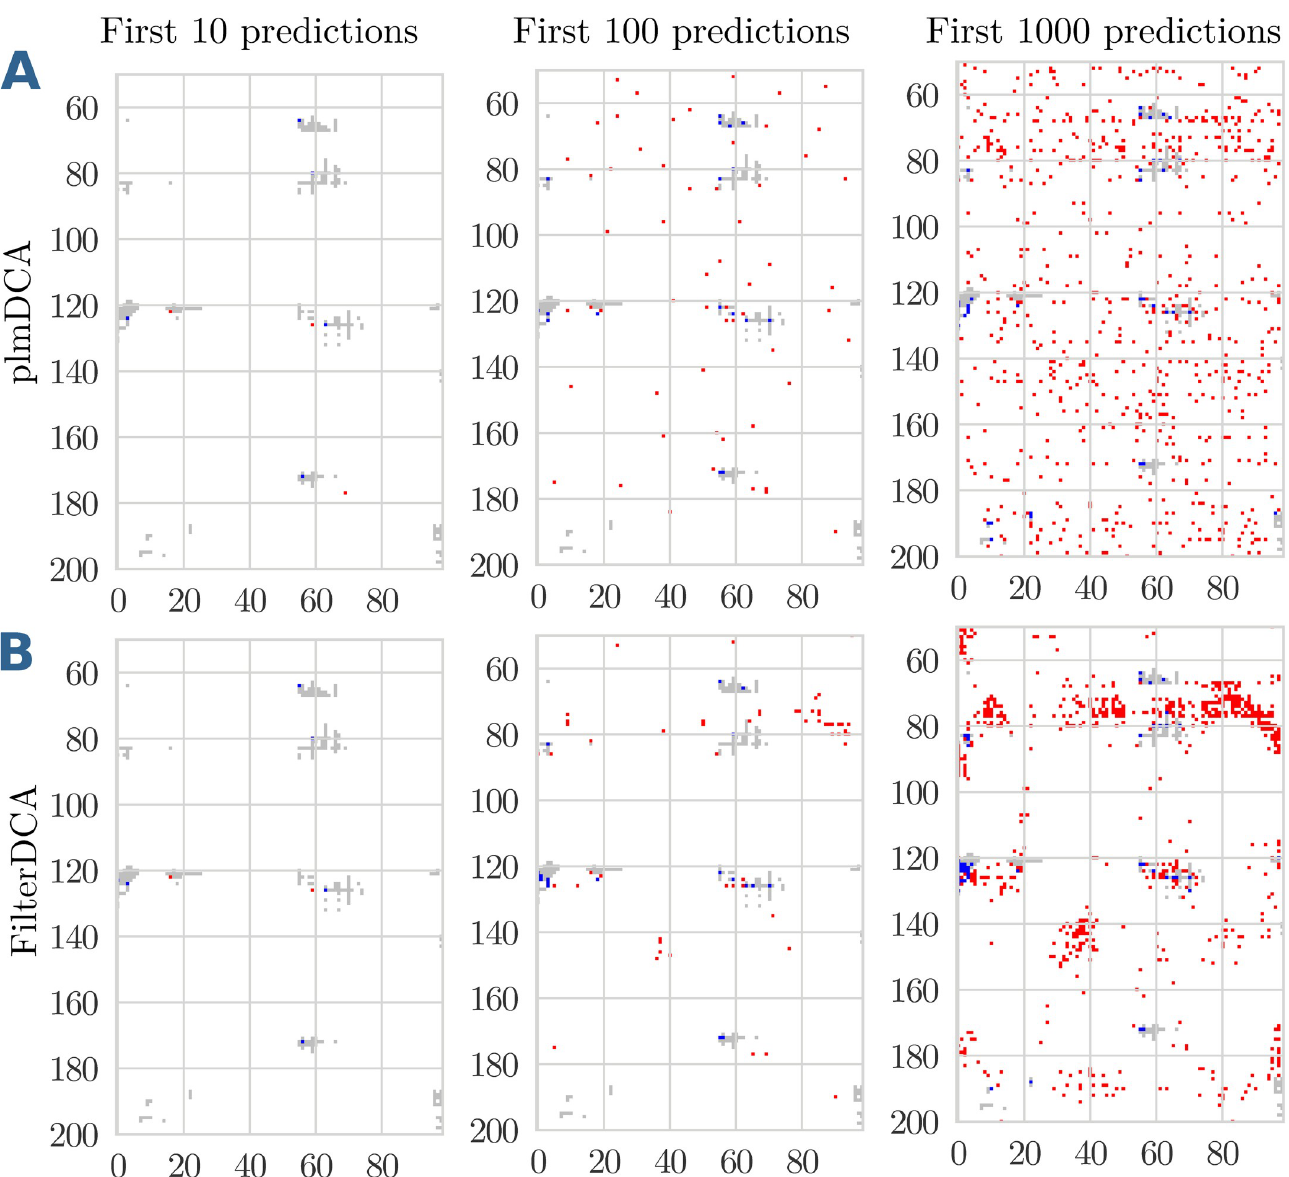
Fig 7. Contact map prediction for the interaction between the domain families PF01557 and PF09298 co-occurring in Fumarylacetoacetate (FAA) hydrolases. The upper panels (A) show the predictions of plmDCA, the lower panels (B) those of FilterDCA, for the first 10, 100 or 1000 predicted contacts. In each figure, the native contacts are shown in grey, TP predictions of the two methods in blue, FP predictions in red. This example shows a case where the plmDCA signal is weak, and consequently cleaning by FilterDCA does lead to a marginal improvement only.